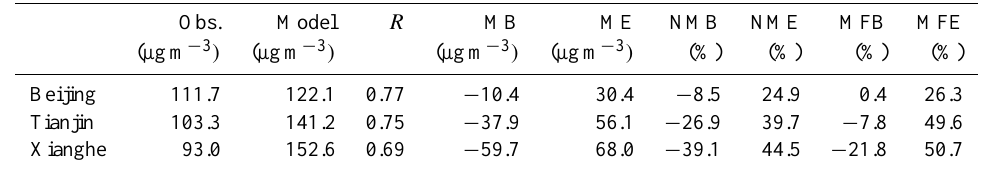
Table 3. Performance statistics of PM 2 . 5 .